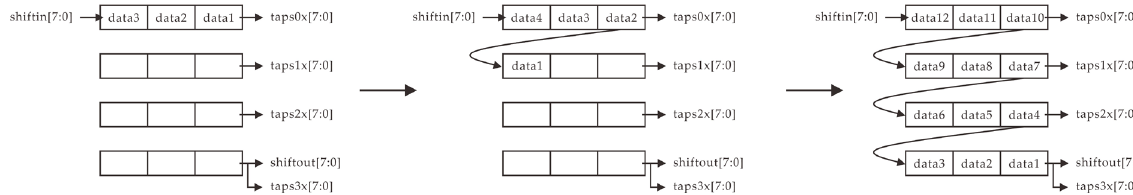
Figure 4. Shift register operation principle.